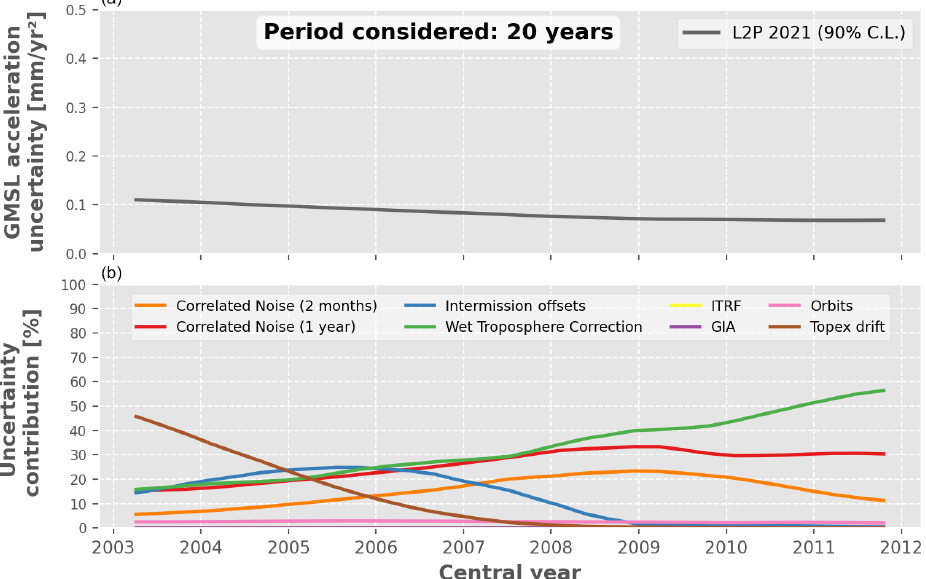
Figure 11. Relative contribution of each uncertainty budget contributor to the GMSL acceleration uncertainty over periods of 20 years. (a) GMSL acceleration uncertainty in the L2P21 record. (b) Relative contribution to the total GMSL acceleration uncertainty (%) of each uncertainty budget contributor, i.e. the altimeters, the radiometers, the orbit determination and the geophysical corrections.